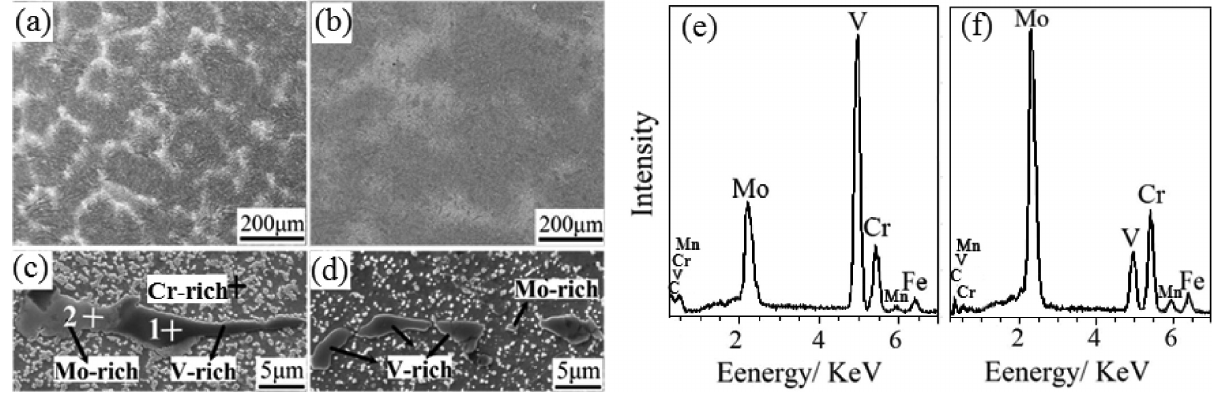
Fig. 1: SEM observation of carbides in H13 steel. (a) and (c) annealed steel, steel A; (b) and (d) forged and annealed steel, steel B; (e) and (f) EDS spectrums of point 1 and